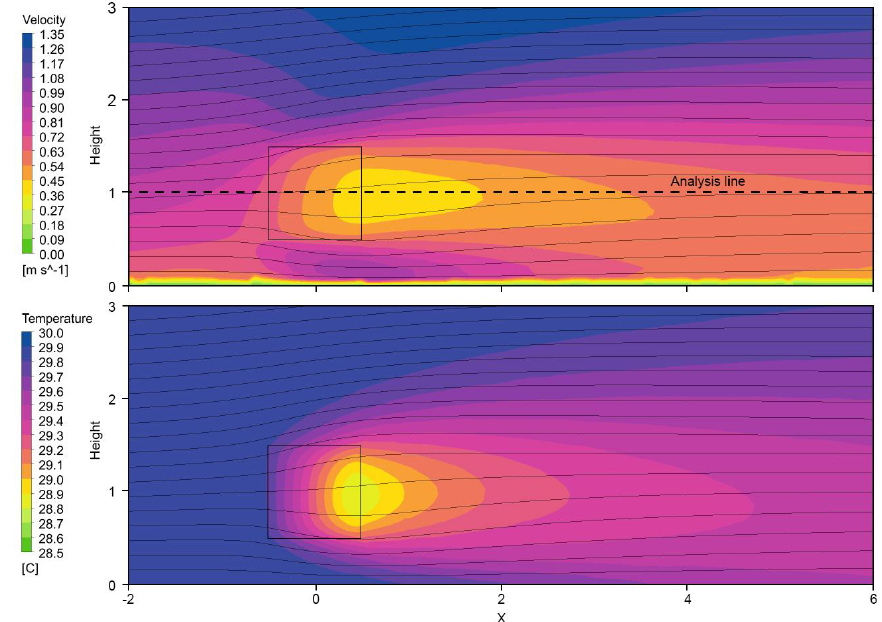
Figure 8. Contours of velocity and temperature around the vegetation (black square) from the validation model.